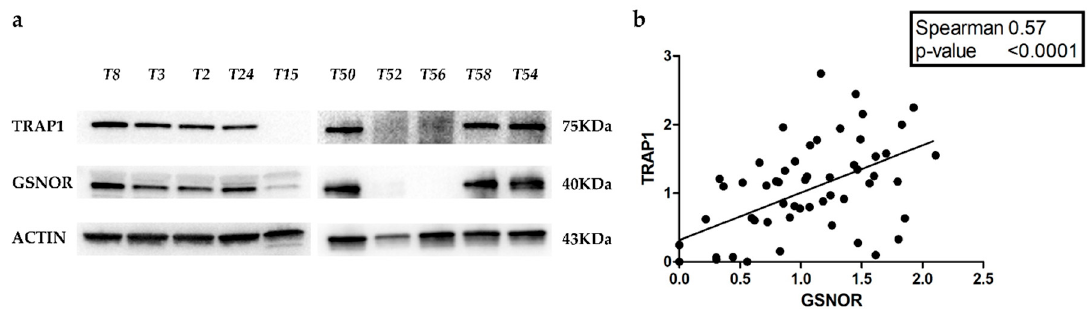
Figure 4. Correlation between TRAP1 and GSNOR protein expression in human colorectal carcinomas. ( a ) TRAP1 and S-nitrosoglutathione reductase (GSNOR) immunoblot analysis in 10 representative cases of human colorectal carcinomas. ( b ) Correlation plot reporting TRAP1 and GSNOR protein expression in 58 human colorectal carcinomas from our cohort ( b ).